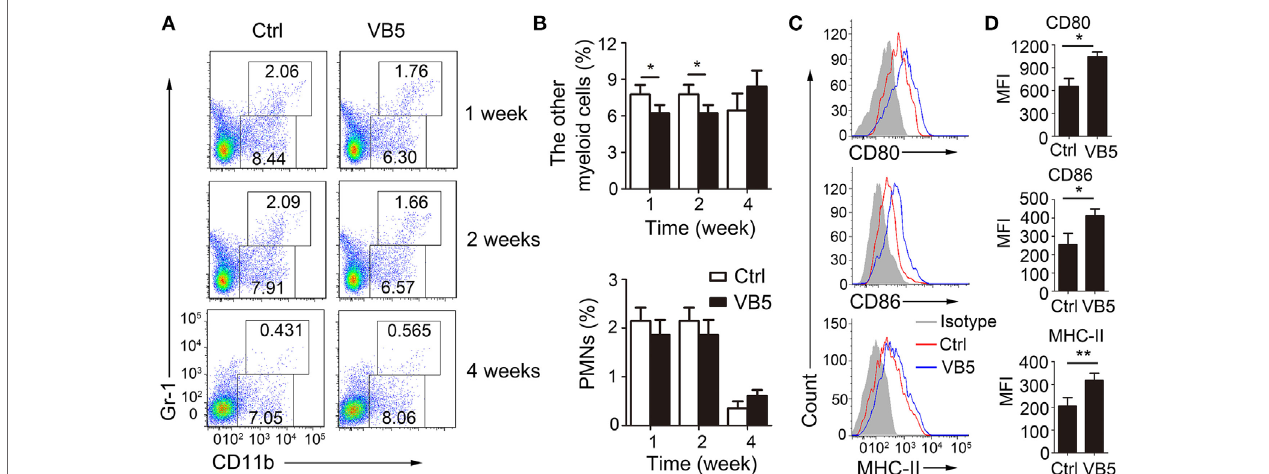
FigUre 5 | The effect of vitamin B5 (VB5) on the percentage of myeloid cells in lungs. Lung cells from H37Rv-infected mice treated with VB5 or untreated were harvested at 1, 2, and 4 weeks after infection. Flow cytometric analysis of lung cells stained with anti-mouse CD11b and anti-mouse Gr-1 antibodies. (a) The percentage of myeloid cells is displayed as dot plots. (B) The percentages of other myeloid cells and polymorphonuclear leukocytes (PMNs) in lungs were shown. (c) The expressions of CD80, CD86, and MHC-II were detected via flow cytometry. (D) The expressions of CD80, CD86, and MHC-II were assessed as mean fluorescence intensity (MFI). Data shown are the mean ± SD. * P < 0.05. Data are representative of three independent experiments with similar